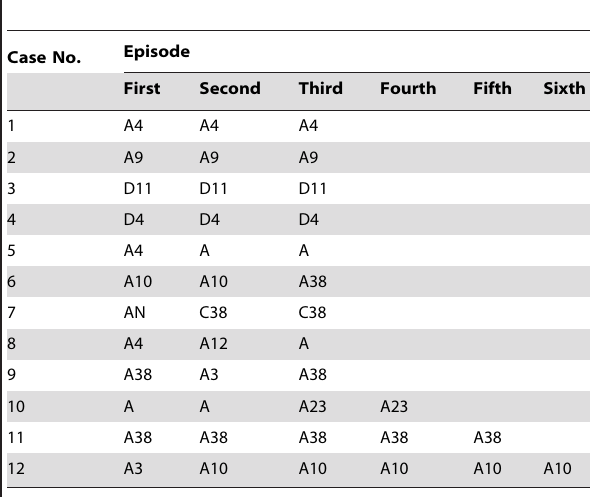
Table 5. Detailed pulsed-field gel electrophoresis patterns of MRSA isolates from 12 children with three or more episodes.